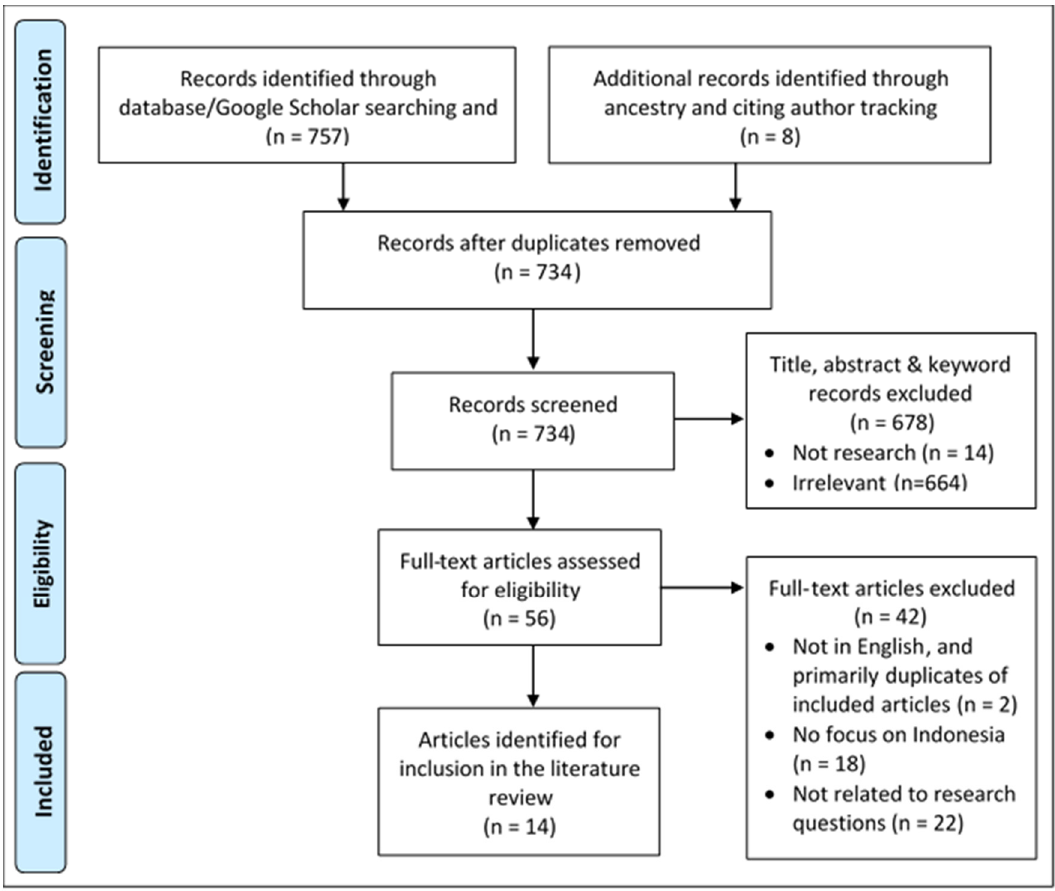
Figure 1. Flow diagram of search and inclusion strategy.